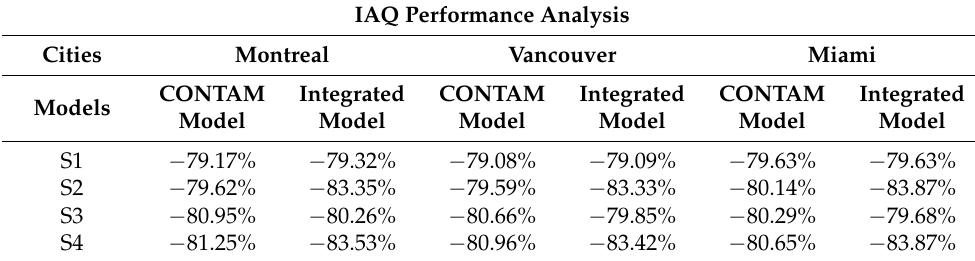
Table 7. IAQ performance analysis results by comparison of average percentage difference of simulated daily indoor CO 2 concentration with ASHRAE Standard 62.1 levels between CONTAM and the integrated